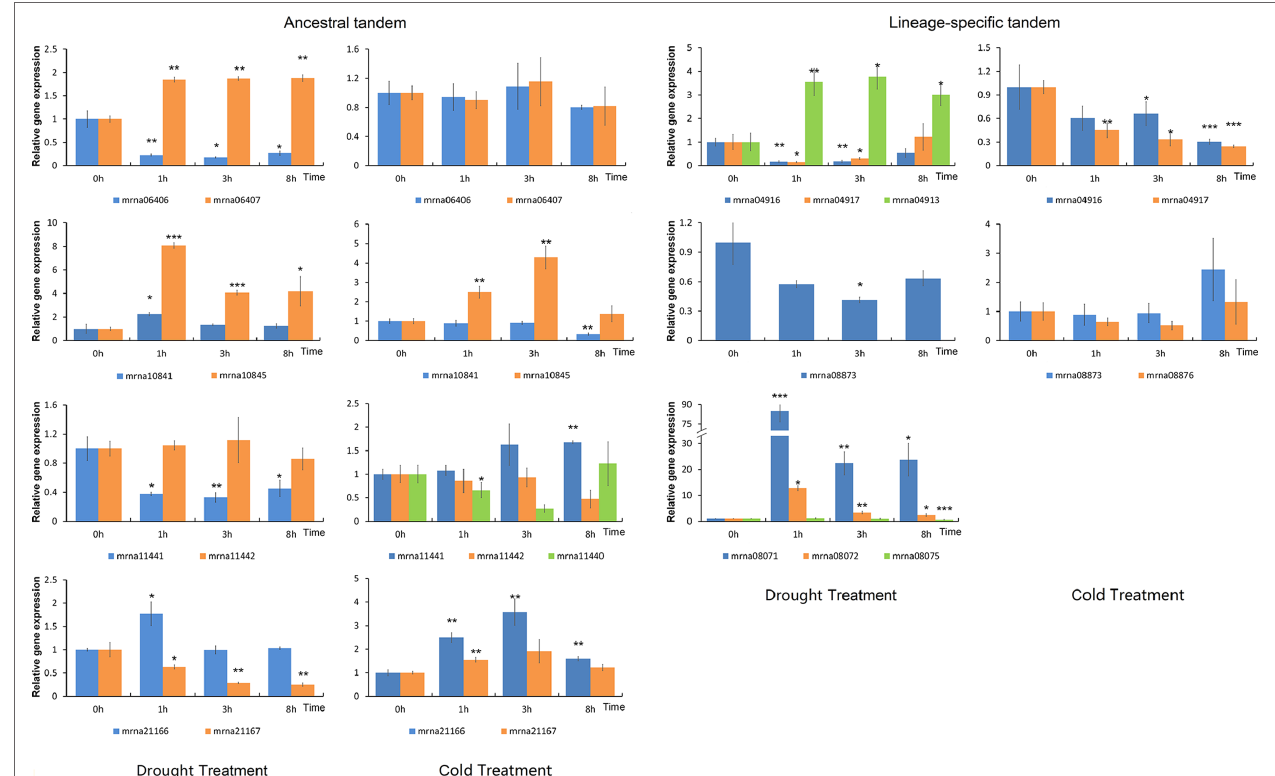
FIGURE 6 | Expression profiles of FveERF genes in response to drought and cold. The expression levels relative to GAPDH were measured by quantitative RT-PCR. Three biological replicates and three technical replicates were obtained for each data point. Asterisks above the error bars indicate significant differences between the treated and untreated (0h) samples (*p < 0.05; **p < 0.01; ***p < 0.001). Mrna08075 forms an ancestral tandem repeat with mrna08071 and mrna08072. The genes with expression levels lower than 1 × 10 −4 at most time points of the treatment are not